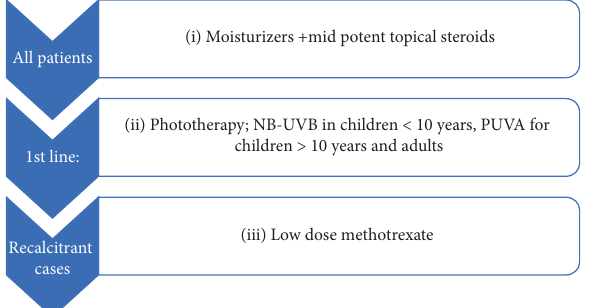
Figure 4: Algorithm for the treatment for hypopigmented MF in